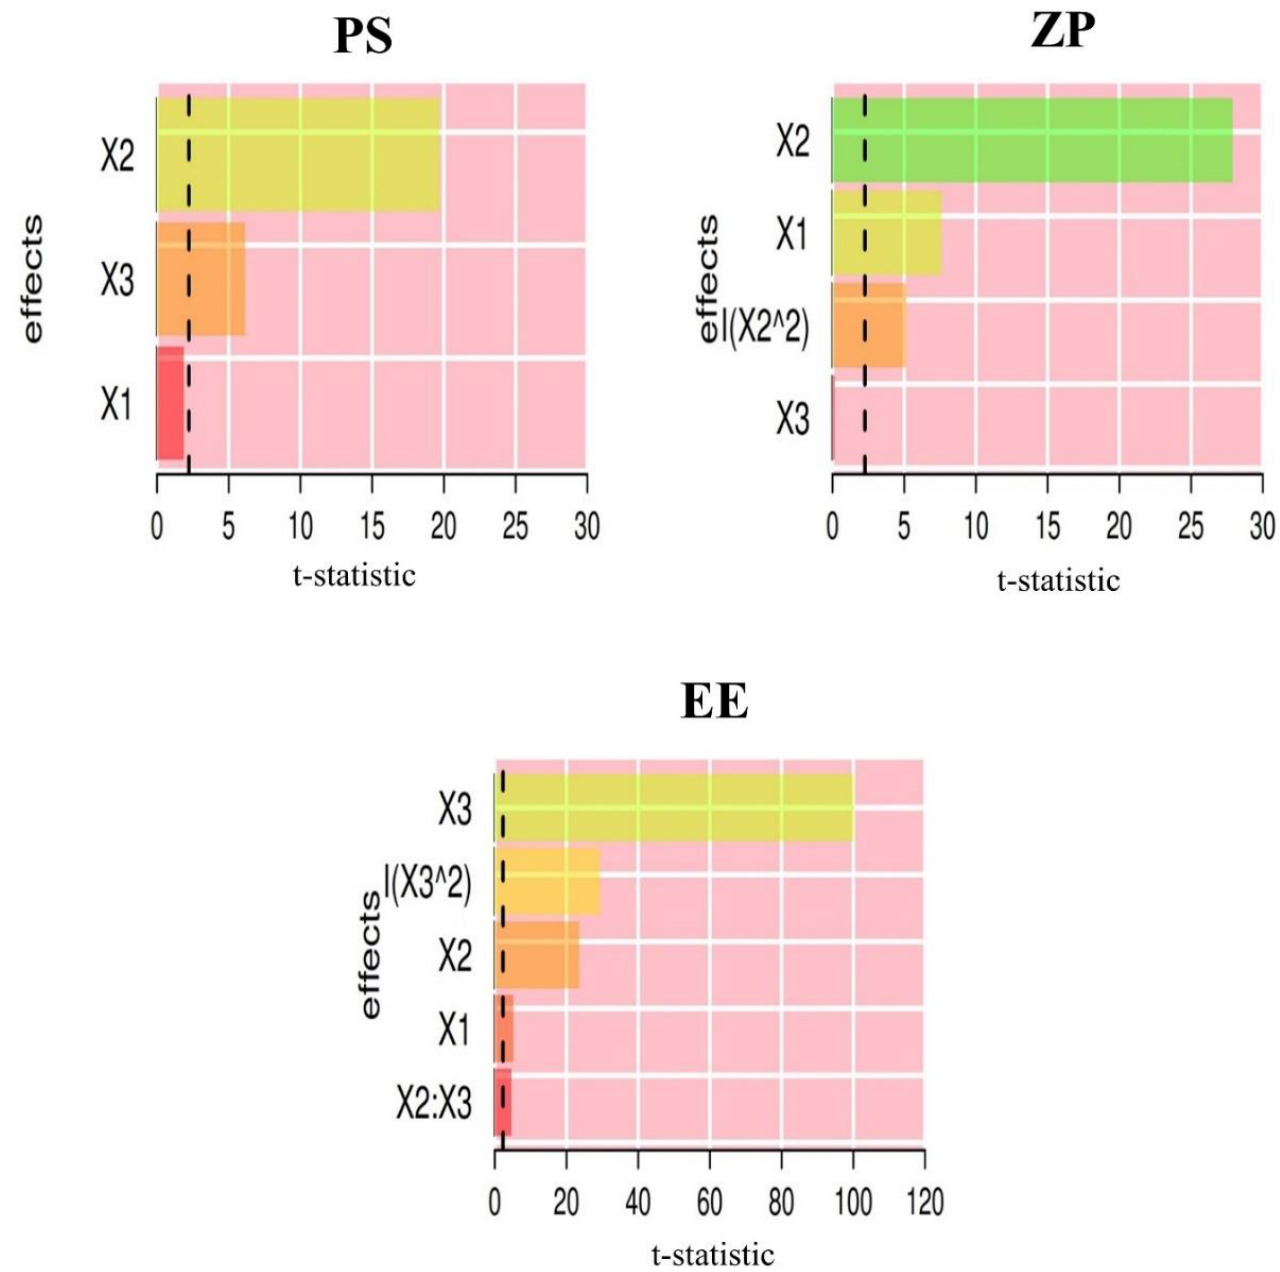
Figure 2. Pareto chart depicts the standardized impacts of LC amount (X 1 ), CTS amount (X 2 ), and IPM concentration (X 3 ). The bars represent the t -statistics (which were calculated as parameter estimate/estimate standard error). The critical t -value is represented by the dashed lines (the 95th percentile of a two-tail t-distribution with error degrees of freedom).